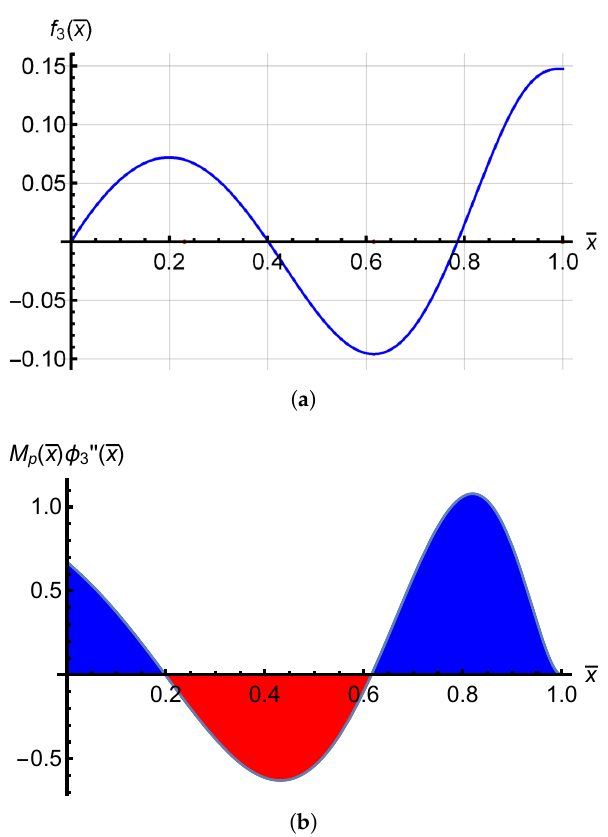
( ¯ x ) . The third mode excitation 3 ( ¯ x ) .The area of this function 3